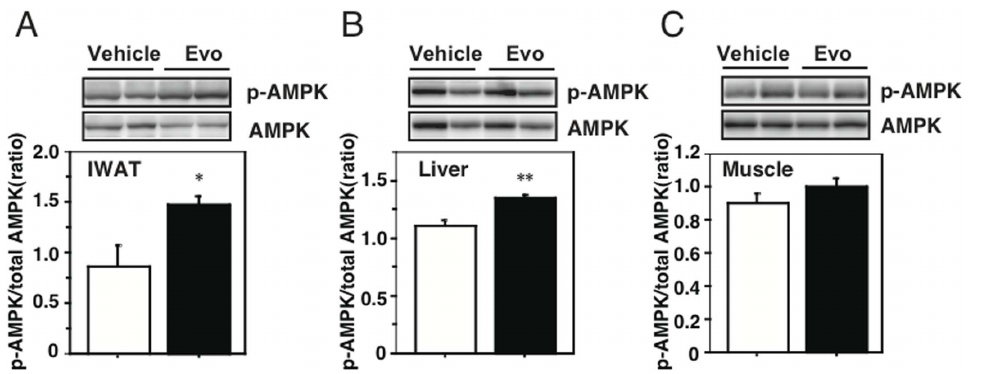
Figure 9. Effect of evodiamine on AMPK phosphorylation in the WAT, liver and sleletal muscle of mice treated with evodiamine. Western blot analysis for AMPK were done with tissue lysates (30 m g protein) of IWAT (A), liver (B) and gastrocnemius muscle (C) from the KK-Ay mice treated with evodiamine for 7 days. Phosphorylation levels of AMPK Thr172 were normalized to its total level. Data are expressed as mean 6 SEM ( n =5). * p , 0.05, ** p , 0.01 vs. vehicle